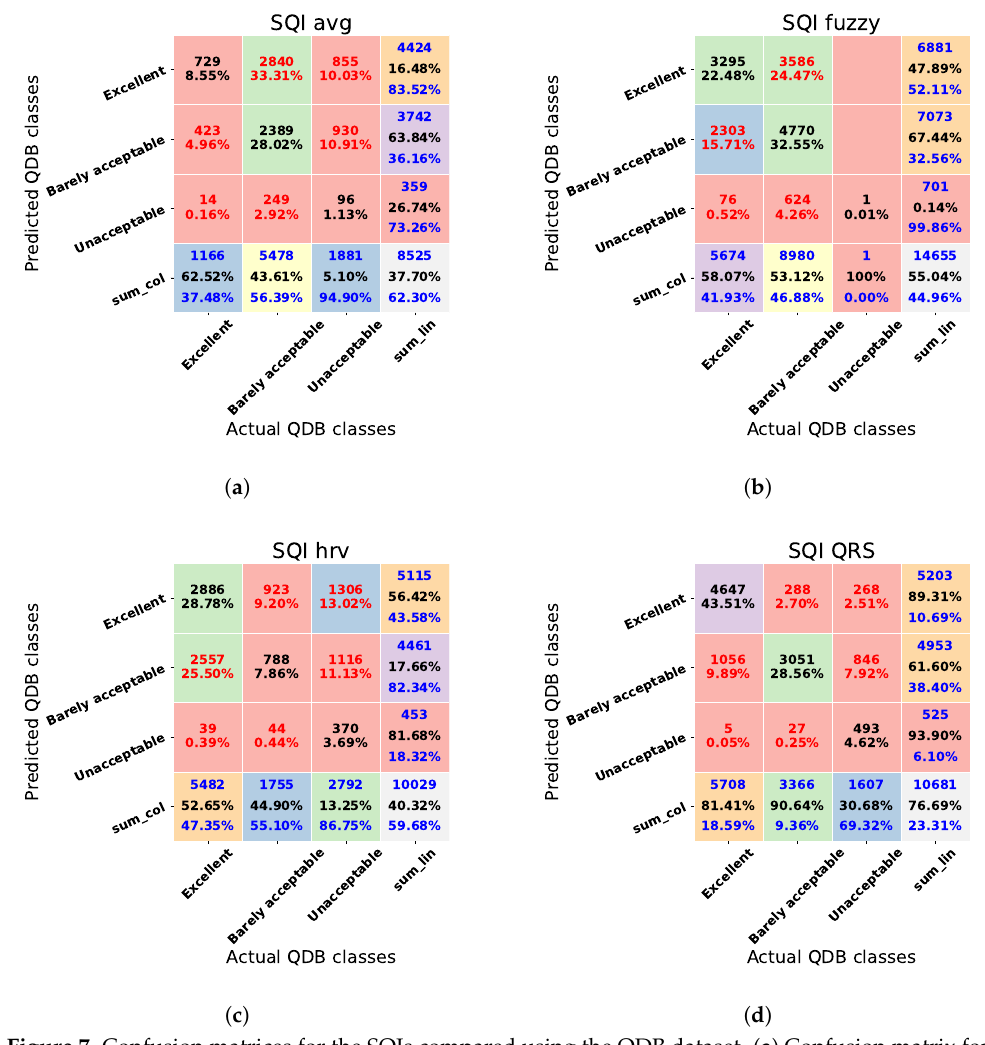
Figure 7. Confusion matrices for the SQIs compared using the QDB dataset. ( a ) Confusion matrix for SQI avg . ( b ) Confusion matrix for SQI fuzzy . ( c ) Confusion matrix for SQI hrv . ( d ) Confusion matrix for SQI QRS . Table 5. Symbols used to report statistical